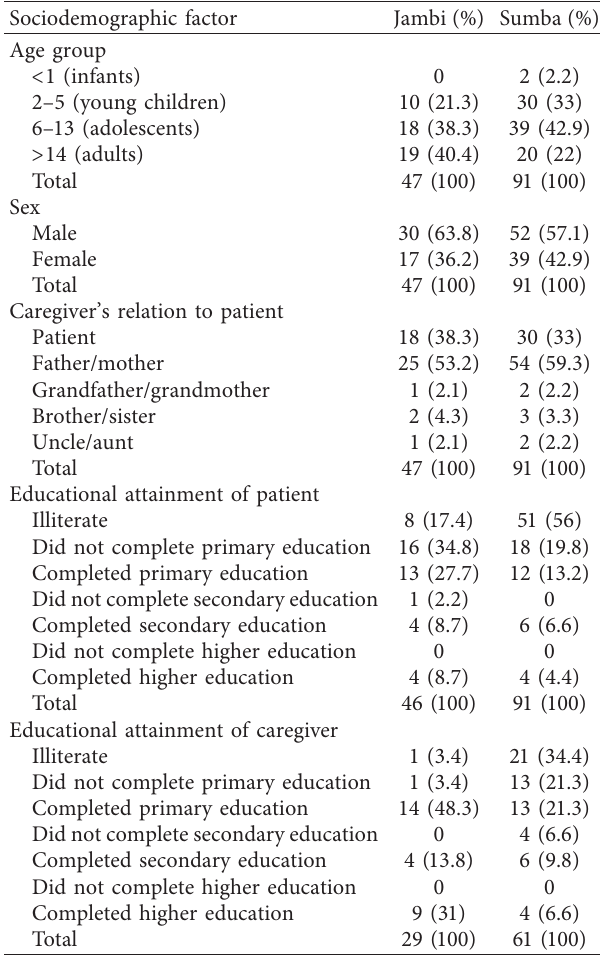
Table 1: The description of sociodemographic variables of the patients and the caregivers in Jambi and